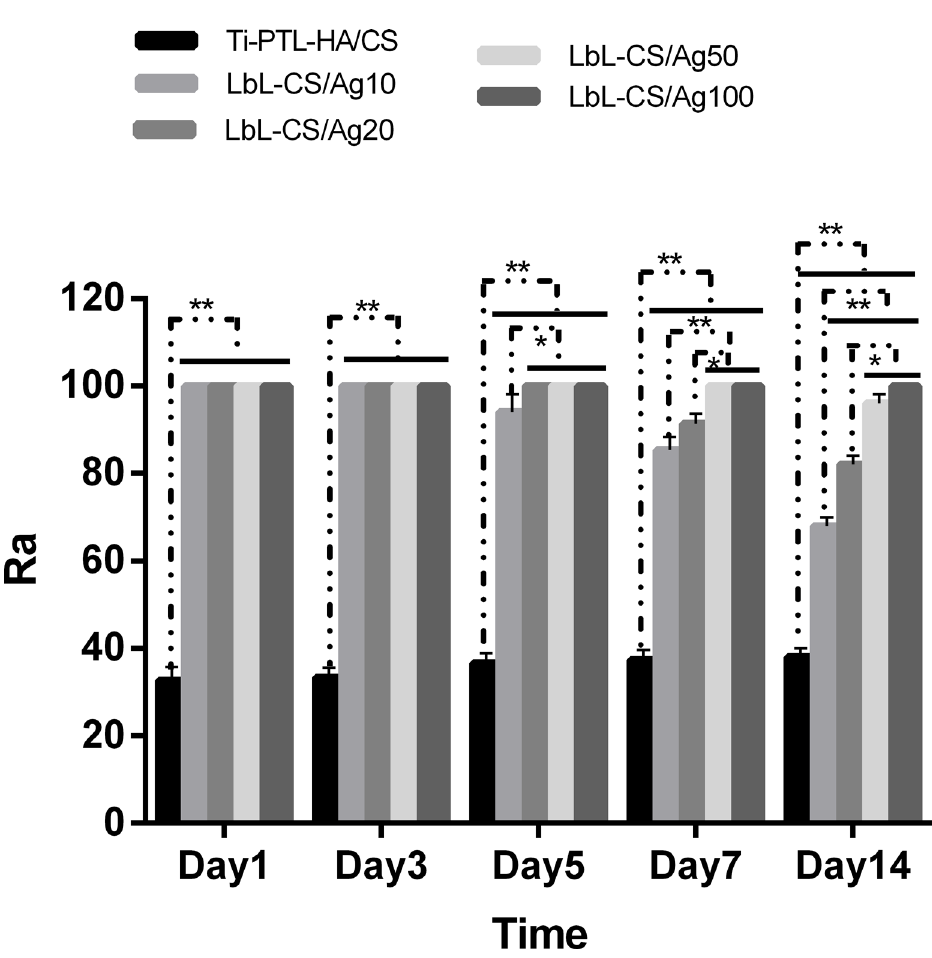
Fig 7. Antibacterial rates against adherent bacteria on the specimens (Ra). The antibacterial assays data are expressed as means ± standard deviations (n = 3). One-way ANOVA followed by SNK post hoc test is utilized to determine the level of significance. * p < 0.05 and ** p <